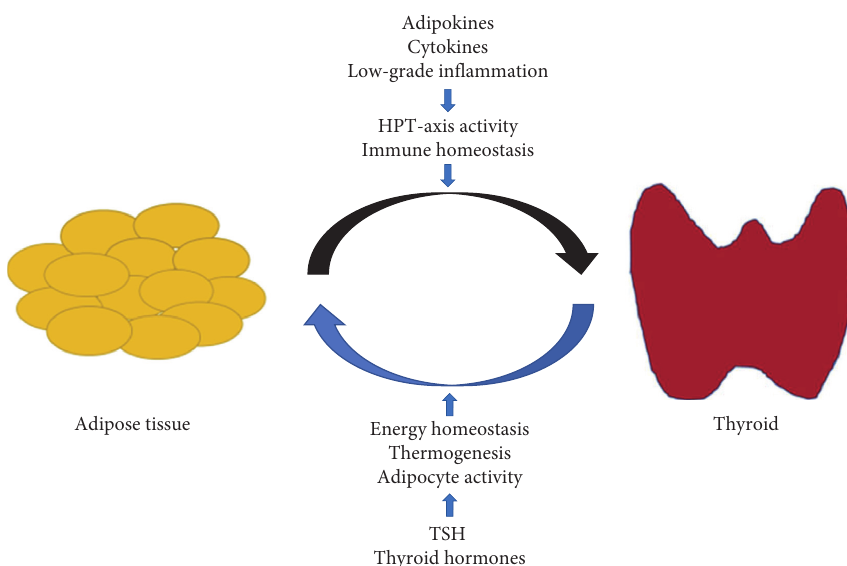
Figure 2: The bilateral relationship between autoimmune thyroid disease/thyroid function and